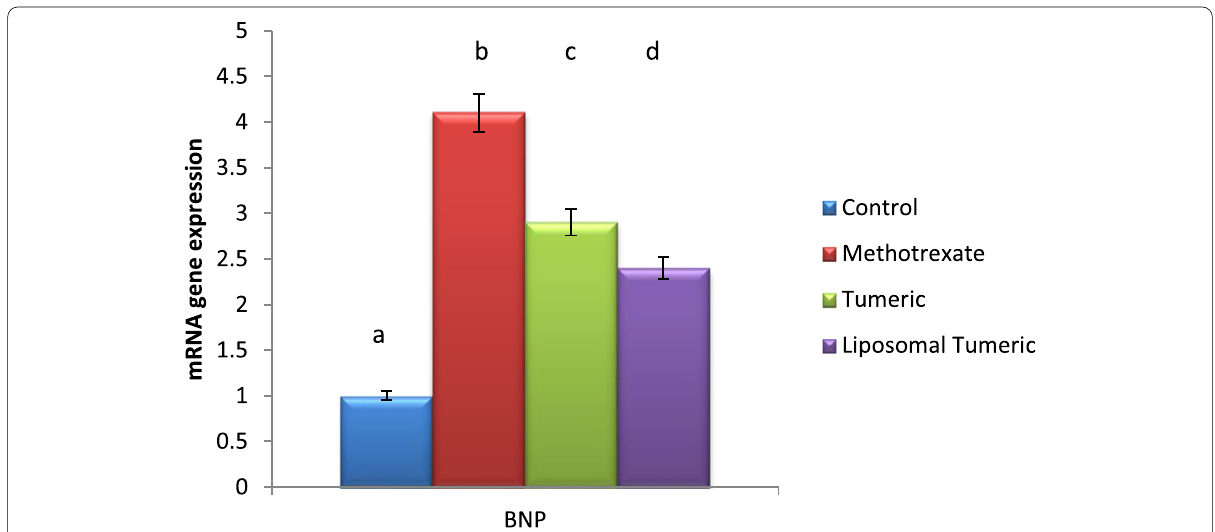
Fig. 6 Impact of turmeric and liposomal turmeric on serum brain natriuretic peptide (BNP) gene expression post methotrexate intoxication. GAPDH was used as an internal control for calculating mRNA fold changes. Data are expressed as mean considered significant. Groups having the same letter are not significantly different from each other, while those having different letters are significantly different from each